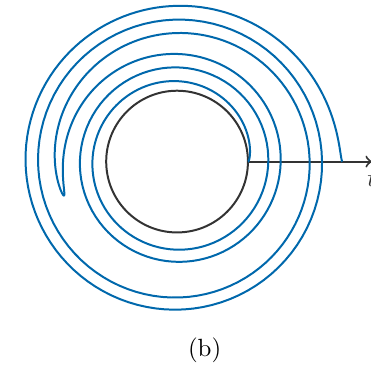
Figure 8. For small oscillations (8a), the axion sees the e(cid:11)ective potential and executes simple har- monic motion. For large oscillations (8b), the axion still executes harmonic motion. However, there is a monodromy. It can wrap around its (cid:12)eld space many times before slowing to a halt and reversing course. This motion cannot be described using an e(cid:11)ective potential on the compact (cid:12)eld